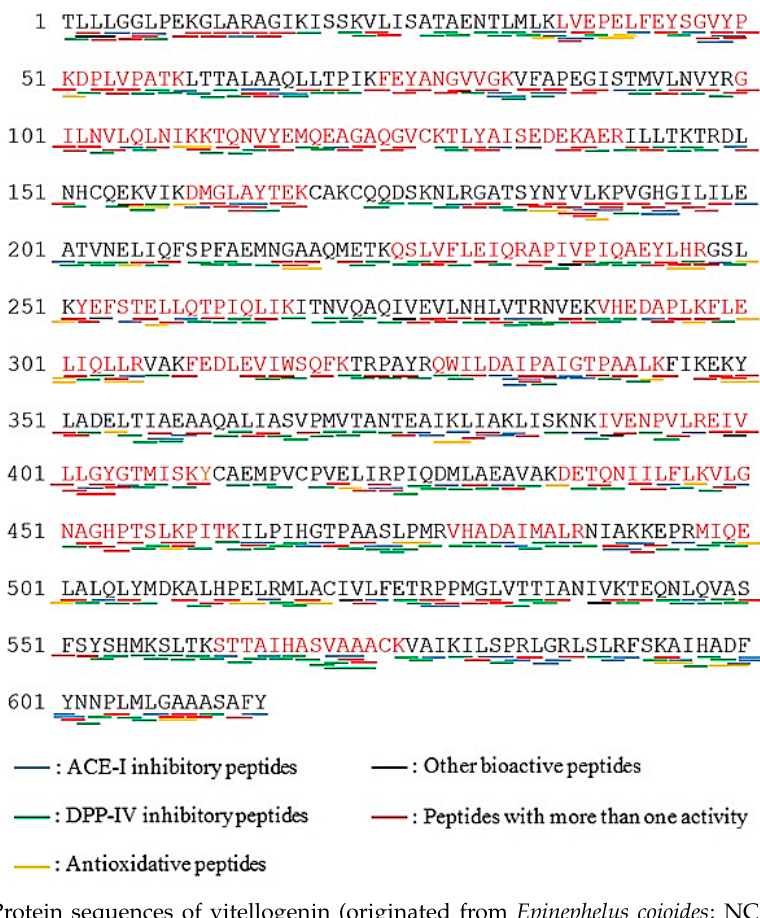
Figure 4. Protein sequences of vitellogenin (originated from Epinephelus coioides ; NCBI accession number: AAW29031.1; Protein sequence coverage: 41%; 615 aa; excised from band B). Matching tryptic fragments were shown in red letters. Underlines presented bioactive peptides